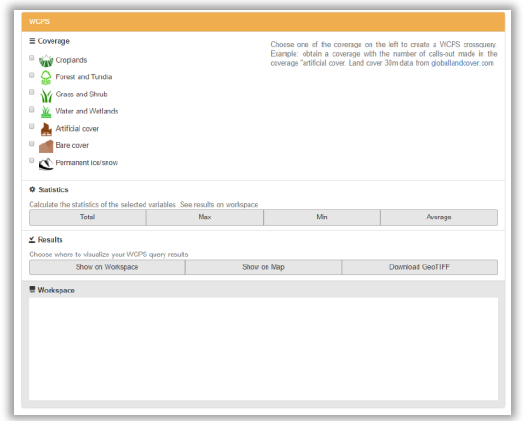
Figure 5. WCPS query second panel